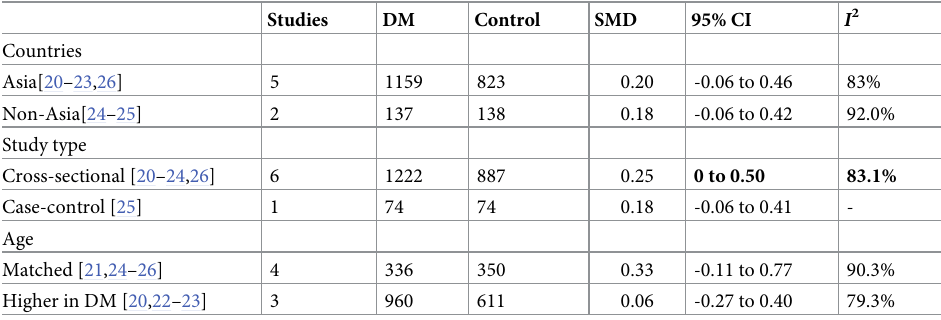
Table 2. Subgroup analysis of the association between circulating Nrg4 levels and DM.